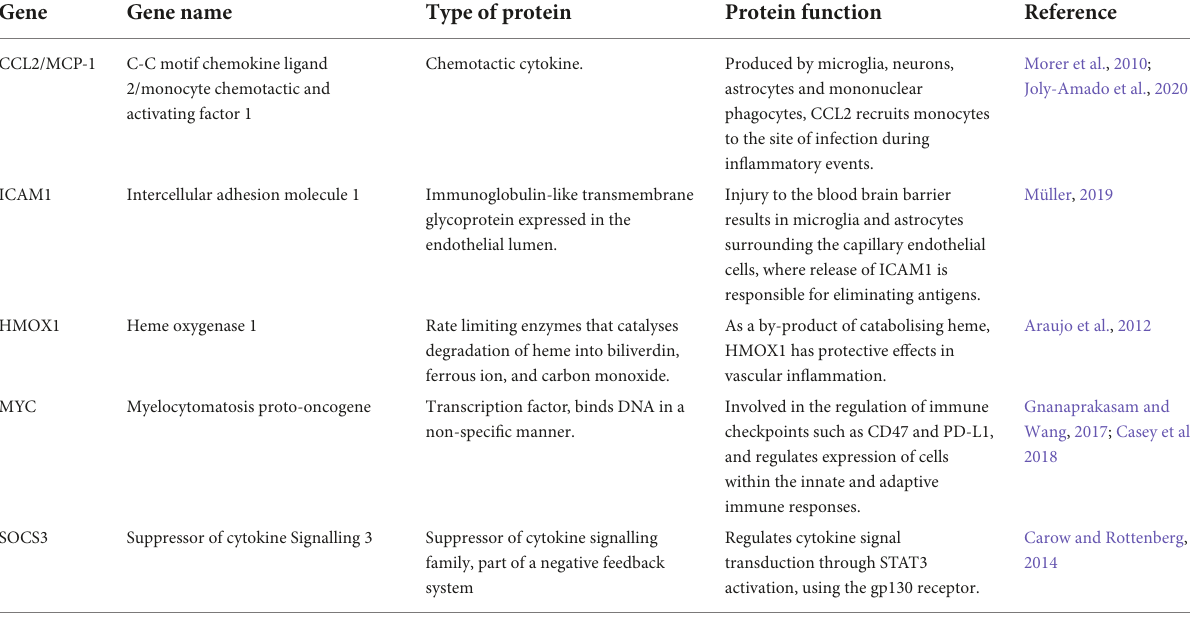
TABLE 1 Up-regulated hub genes in autism spectrum disorders (ASD) and Tourette syndrome